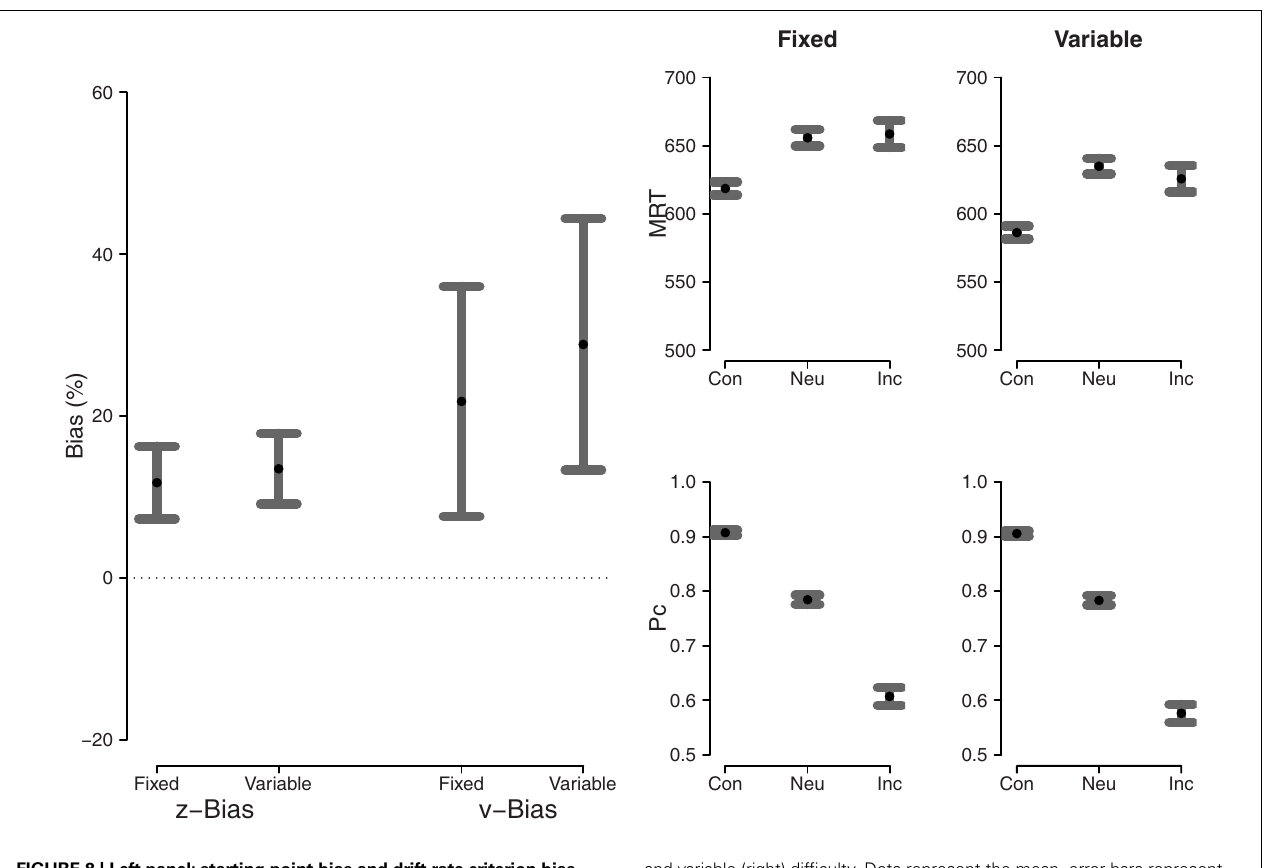
FIGURE 8 | Left panel: starting point bias and drift rate criterion bias. Right four panels: MRT (top) and proportion correct (bottom) for fixed (left)